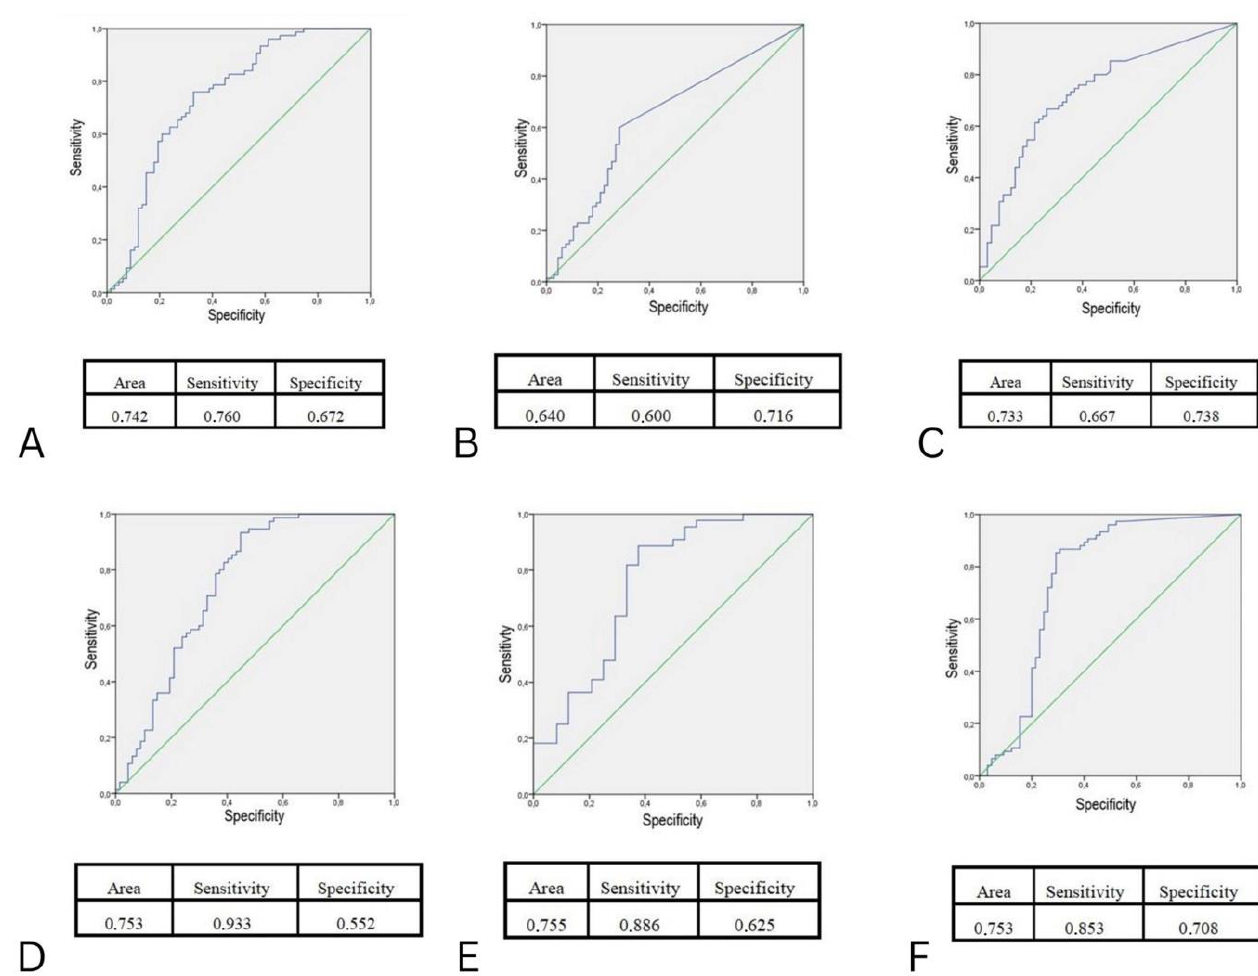
Figure 1. ( A ) ROC curve showing the relationship between sensitivity and specificity of CRP in patients with ulcerative colitis and its influence on the development of atherosclerosis (AUC = 0.742, sensitivity 76.0%, specificity 67.2%). ( B ) ROC curve showing the relationship between sensitivity and specificity of IL-6 in patients with ulcerative colitis and its influence on the development of atherosclerosis (AUC = 0.640, sensitivity 60.0%, specificity 71.6%). ( C ) ROC curve showing the relationship between sensitivity and specificity of TNF- α in patients with ulcerative colitis and its influence on the development of atherosclerosis. (AUC = 0.733, sensitivity 66.7%, specificity 73.8%). ( D ) ROC curve showing the relationship between sensitivity and specificity of Ag PLT ADP in patients with ulcerative colitis and its influence on the development of atherosclerosis (AUC = 0.753, sensitivity 93.3%, specificity 55.2%). ( E ) ROC curve showing the relationship between sensitivity and specificity of Ag PLT ASPI in patients with ulcerative colitis and its influence on the development of atherosclerosis (AUC = 0.755, sensitivity 88.6%, specificity 62.5%). ( F ) ROC curve showing the relationship between sensitivity and specificity of Ag PLT TRAP in patients with ulcerative colitis and its influence on the development of atherosclerosis (AUC = 0.753, sensitivity 85.3%, specificity 70.8%).